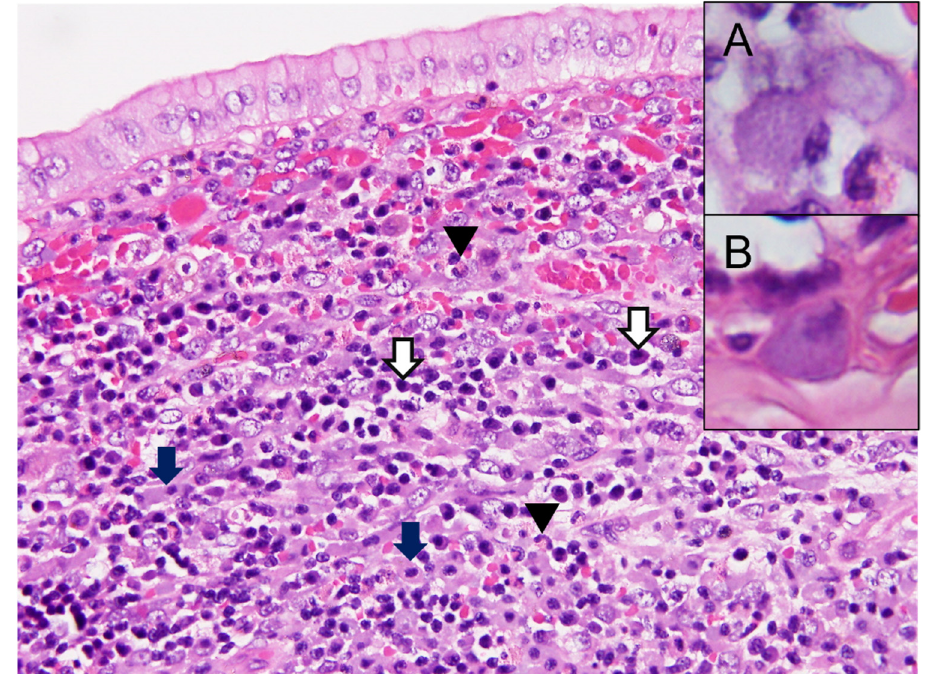
Figure 6. Gastric mast cell tumor, African dormouse, Hematoxylin and eosin. In the lamina propria, the tumor cells in sheet or cord patterns are mildly polymorphic (arrows) and are admixed with moderate number of eosinophils (arrowheads) and plasma cells (hollow arrows) (400×). There are amphophilic granules within the cytoplasm of neoplastic cells (inset A ) (1000×). These features can also be observed in normal mucosal mast cells (MMCs) in the small intestine (inset B ) (1000×).